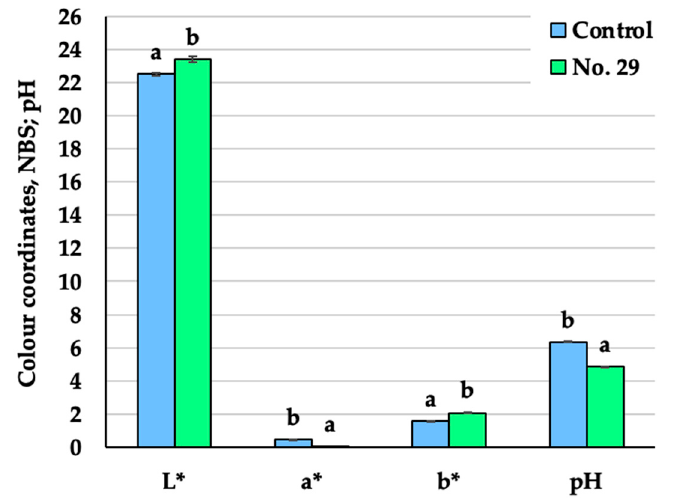
Figure 2. Changes in the pH values and colour coordinates in the Spirulina samples (Control—Spirulina powder and water mixture, 1:2 w / w ; No. 29—Spirulina samples fermented for 24 h with Pediococcus acidilactici, strain No. 29; L*—lightness; a*—redness or − a*—greenness; b*—yellowness or − b*—blueness; NBS—National Bureau of Standards units. Data are represented as means (n = 6) ± standard error. a–b mean values denoted with di ff erent le tt ers indicate signi fi cantly di ff erent values between the samples ( p ≤ 0.05)).